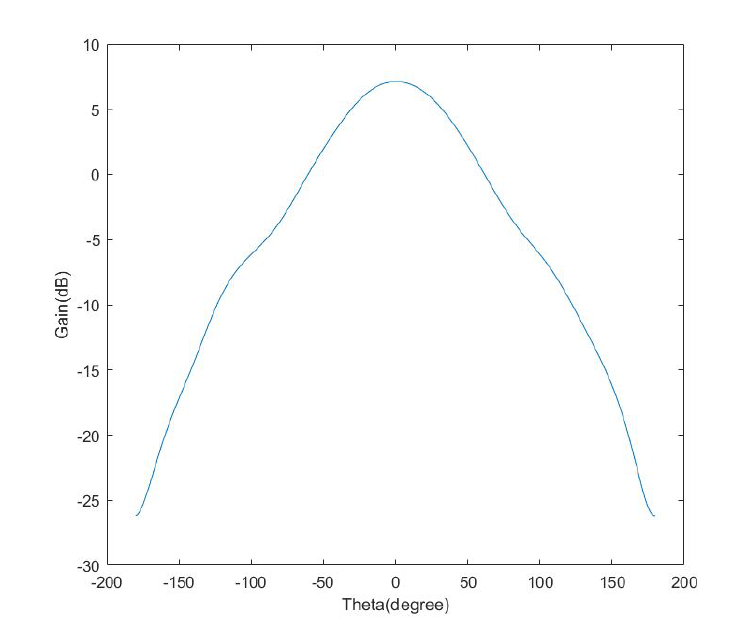
Figure 5. Radiation pattern of the antenna